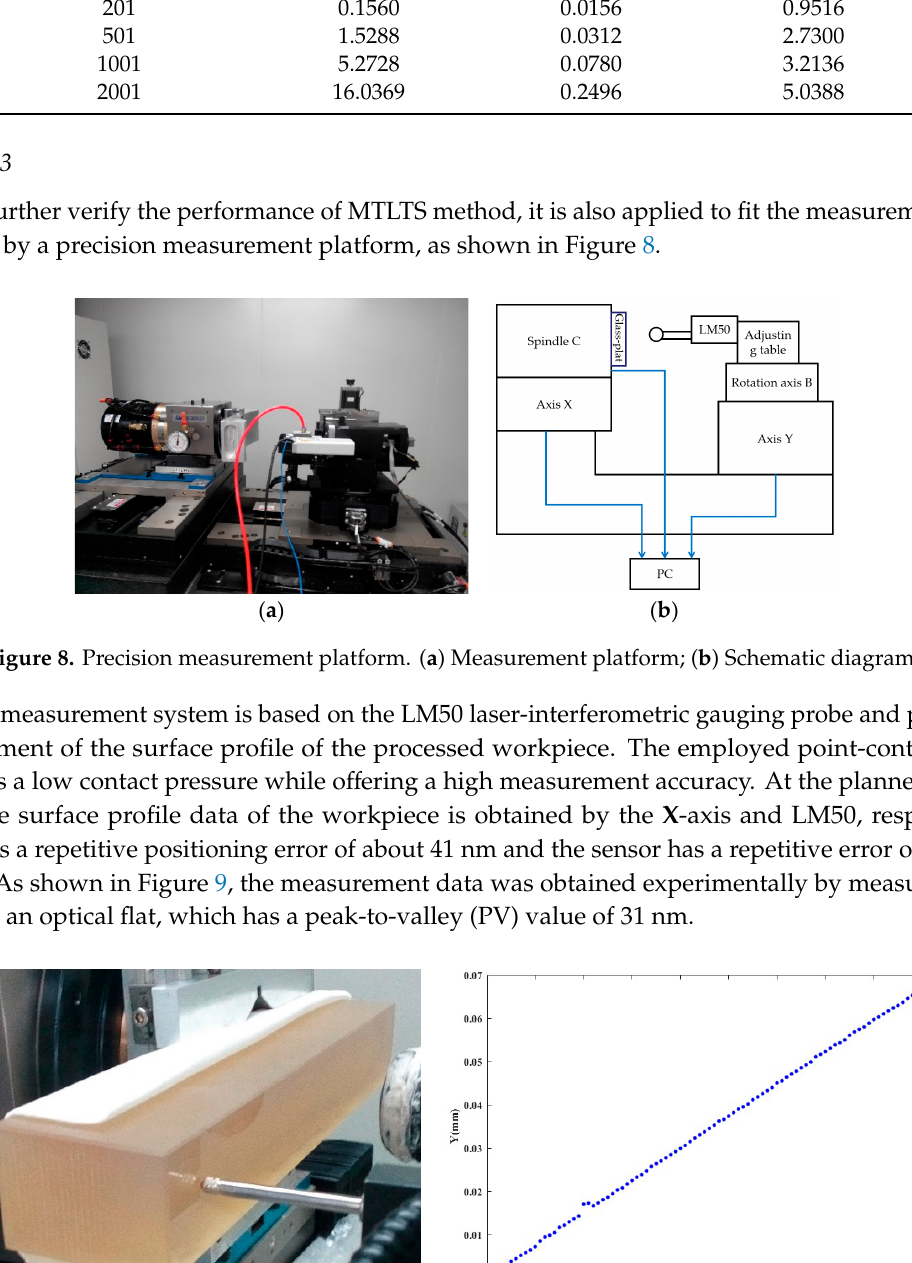
Table 5. The corresponding CPU-times amongst MTLTS, MLS, and MTLS for Case I.